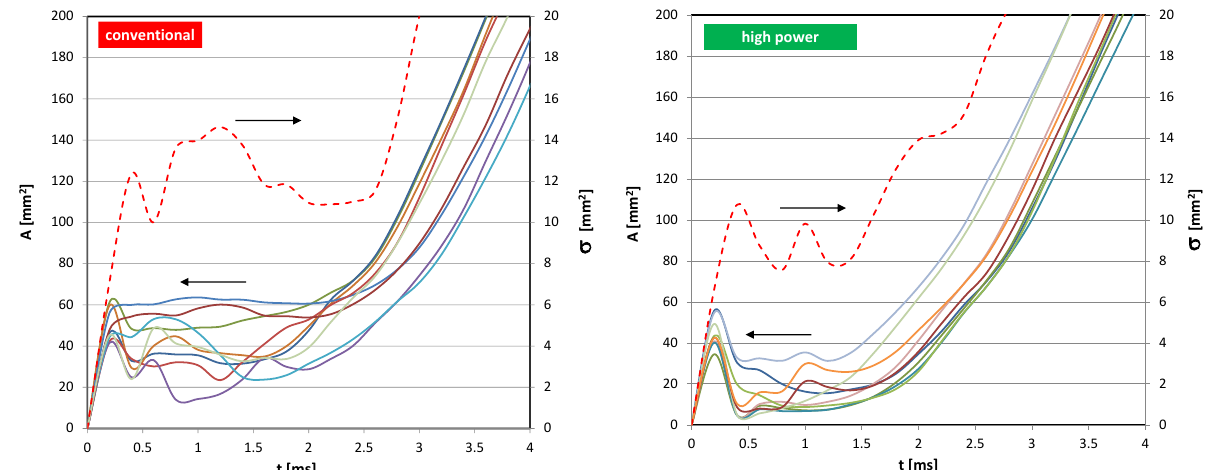
Fig. 8. Flame surface area as a function of time (solid line) and its standard deviation (dashed line) for the early stage of flame development; on the left - conventional ignition, on the right - high-power